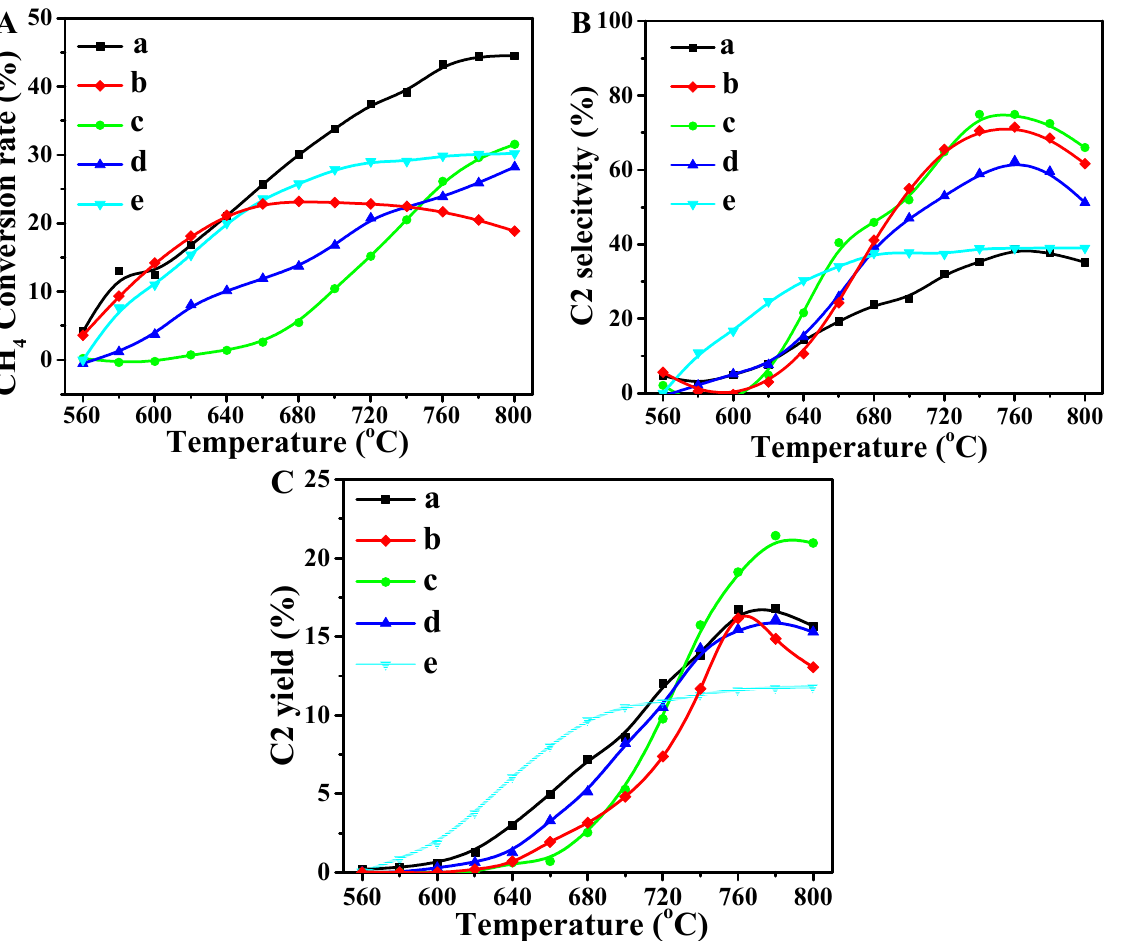
Figure 8. Catalyst conversion ( A ), selectivity ( B ) and yield ( C ) of C2 products over the La 2 O 3 and X- La 2 O 3 catalysts. ( a ) La 2 O 3 ; ( b ) Li-La 2 O 3 ; ( c ) Mg-La 2 O 3 ; ( d ) Zn-La 2 O 3 ; ( e ) Ce-La 2 O 3 .